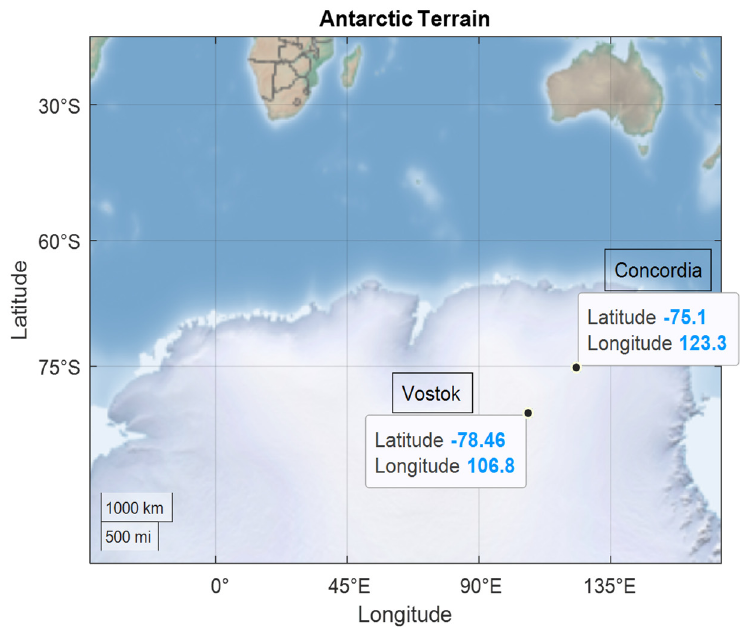
Figure 3. Locations of Concordia and Vostok Stations in Antarctica.